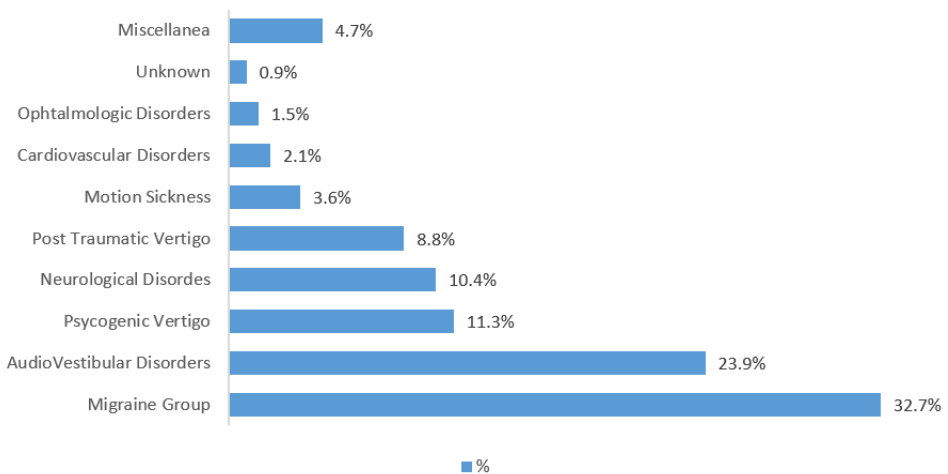
Figure 2. Overall (percentage %) distribution of different aetiologies. “Miscellanea” refers to spo- radic diagnoses, such as metabolic or dental disorders, systemic illness, and other otherwise not specified diagnosis.